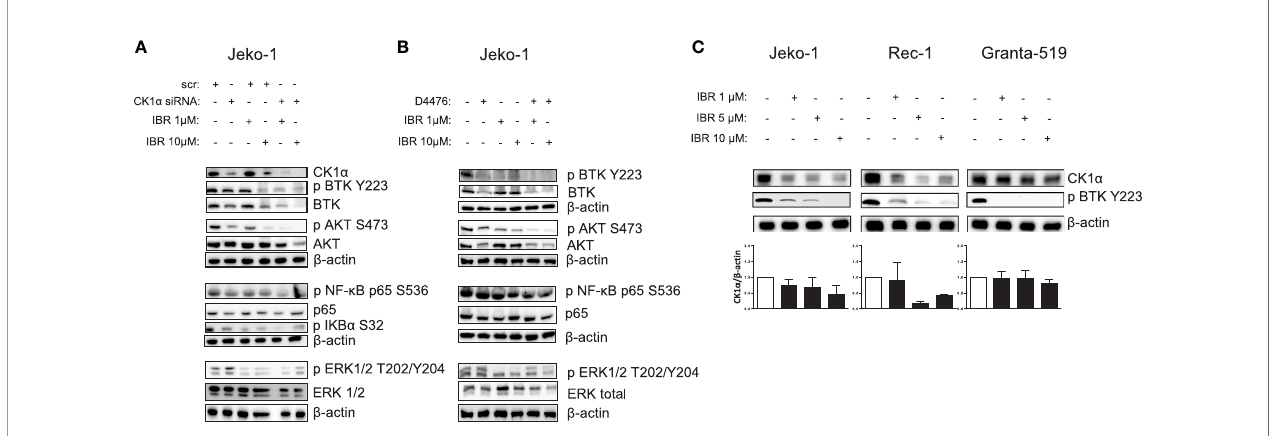
FIGURE 7 | Ibrutinib cooperates with CK1 inactivation in modulating BCR dependent signaling cascades, reducing also CK1 a expression. (A, B) Representative WB of NF-kB p65, BTK, AKT, ERK1/2 dependent phosphorylation and total protein expression in Jeko-1 cells electroporated with CSNK1A1 directed siRNA for 48h (A) , and in Jeko- 1 exposed to D4476 40 µM for 48h (B) , treated with Ibrutinib (IBR) 1 µM or 10 µM for the last 24h. b actin was used as loading control. The fi gure shows a representative WB, that was performed on at least 3 independent experiments. (C) Representative WB (upper panel) and densitometric analysis (lower panel) of CK1 a protein expression in Jeko-1, Rec-1, Granta-519 MCL cells, treated with Ibrutinib 1µM, 5µM and 10 µM for 24h, of three (Jeko-1), two (Rec-1), four (Granta-519) independent experiments. b actin was used as loading